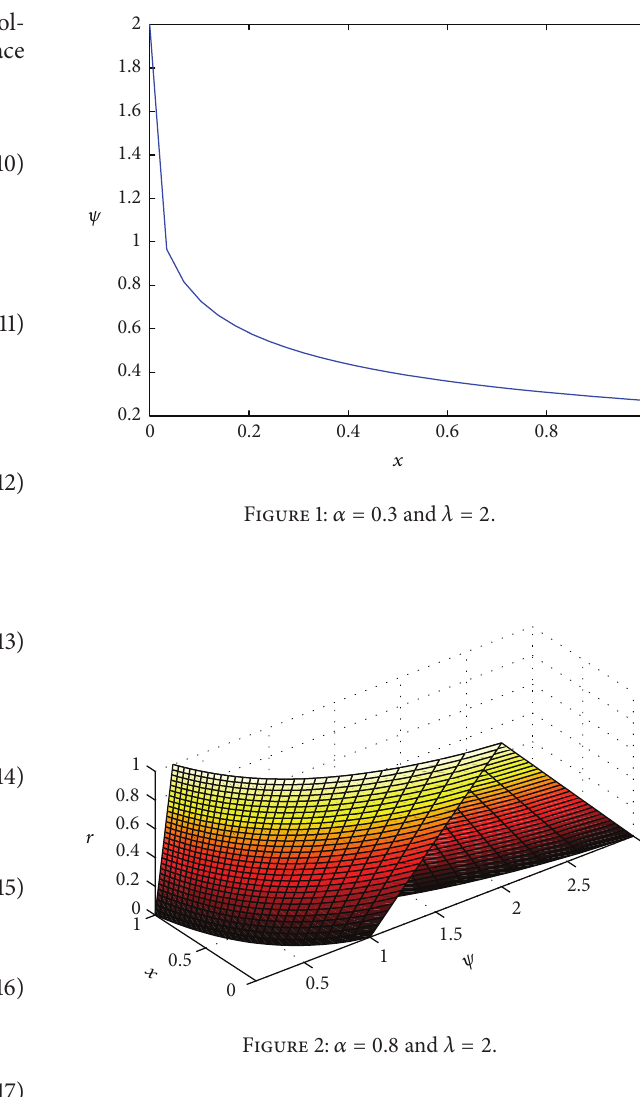
Figure 2: 𝛼 = 0.8 and 𝜆 = 2 .